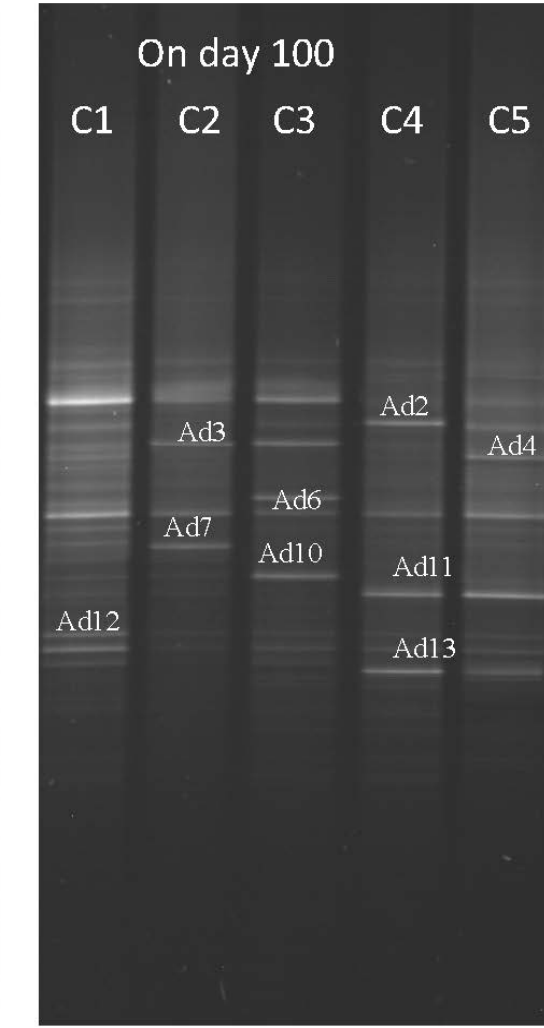
Figure 7. Denaturing gradient gel electrophoresis (DGGE) fingerprints from each compartment of the reactor on Days 2 and